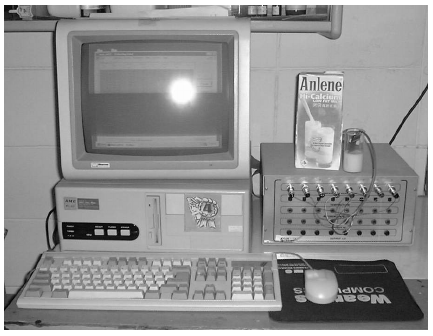
Figure 2. The disposable taste sensor